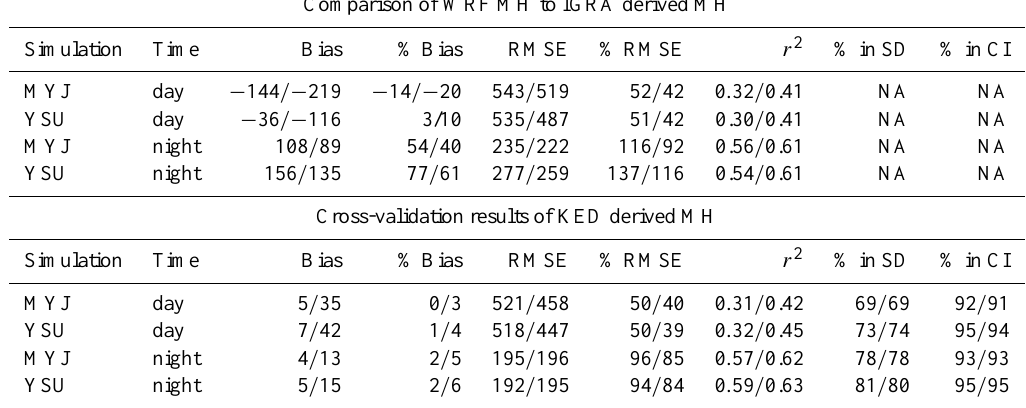
Table 2. Results of the comparison of WRF and IGRA RS-derived MHs based on Eq. (1) (upper panel) and cross-validation results (lower panel) for day (12:00UTC) and night (00:00UTC). Results are shown for both PBL parameterizations: MYJ and YSU. The values in the tables denote the results without and with considering the MH uncertainty shown in the format: without/with MH uncertainty considered. The MH uncertainty was derived as described in Sect. 2.2.1. Bias and random error were normalized by the mean observed IGRA derived MH (columns % Bias, % RMSE). When taking MH uncertainty into account the normalization was done with a weighted mean. Column % SD refers to the number of observations within one standard deviation of the KED estimate and % CI to the observations within the 95.42% confidence